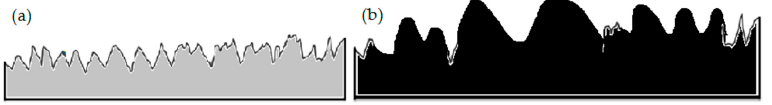
Figure 9. Topography profile of samples in dry conditions ( a ) and after water exposure ( b ).